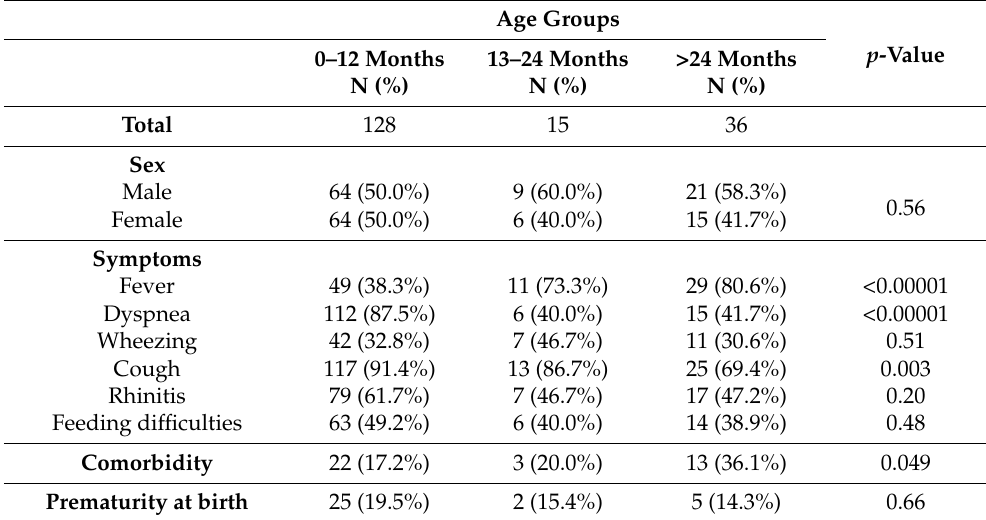
Table 2. Comparison of demographic and clinical data of children hospitalized for RSV infection by age